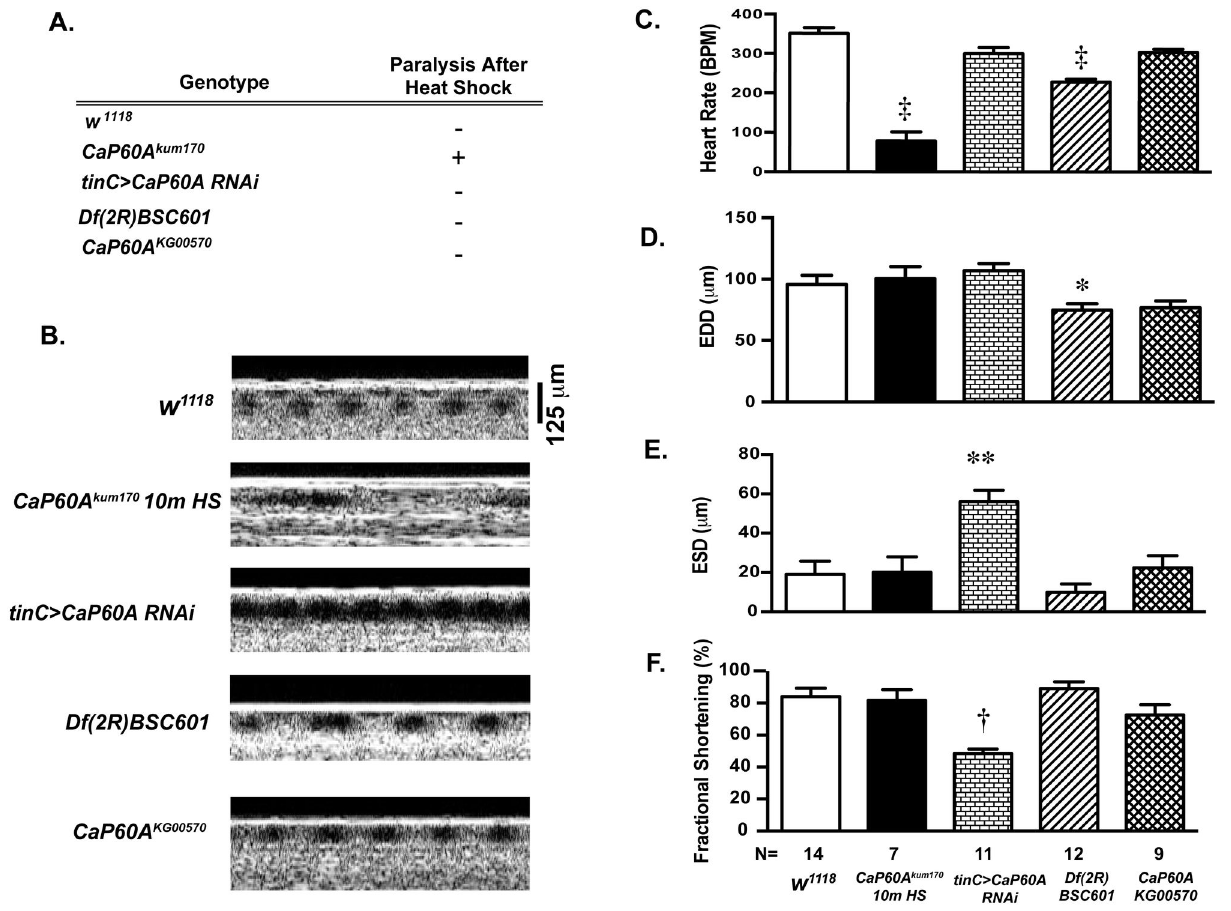
Figure 4. The effects of loss of CaP60A function on cardiac parameters. A . Heat shock did not induce paralysis in flies with cardiac specific CaP60A RNAi ( tinC>CaP60A RNAi ), heterozygous deletion of CaP60A ( Df (2R) BSC601 ), heterozygous p-element disruption of CaP60A ( CaP60A KG00570 ), or w 1118 compared to CaP60A kum170 . B . Representative OCT images in w 1118 , CaP60A kum170 after 10 minute heat shock, tinC>CaP60A RNAi , Df (2R) BSC601 and CaP60A KG00570 ; A 125 micron standard and one second bar are shown, C. Heart rate, D. End Diastolic Dimensions (EDD), E. End Systolic Dimensions (ESD) and F . Fractional shortening (%) in w 1118 , CaP60A kum170 after 10 minute heat shock, tinC>CaP60A RNAi , Df (2R) BSC601 and CaP60A KG00570 . †p<0.001 vs. w 1118